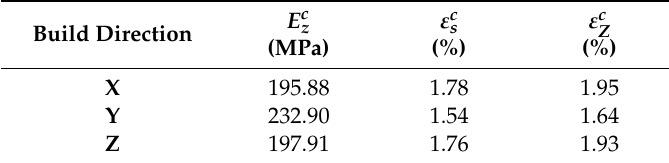
Table 6. Equivalent elastic moduli and strains at t = 0 and t → ∞